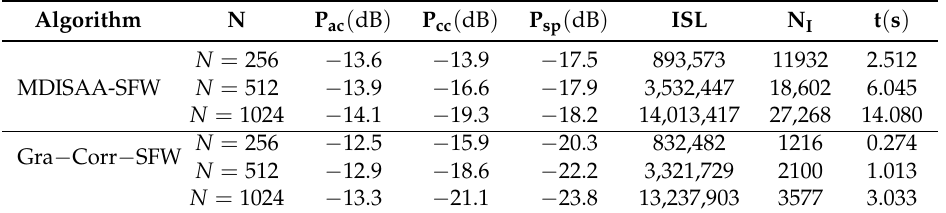
Table 5. The comparison of the performance parameters between MDISAA-SFW and Gra-Corr-SFW.